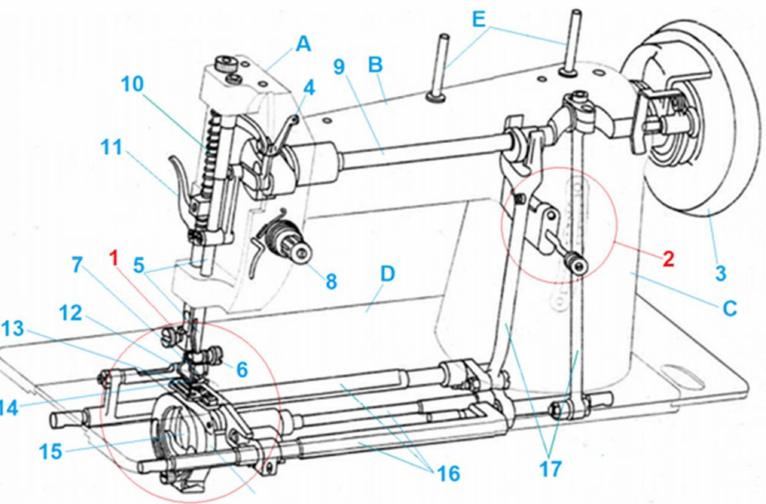
Figure 1. General structure and kinematic system of a lockstitch machine. (A) Sewing Head, (B) Horizontal Arm, (C) Upright Arm, (D) Machine Bed, (E) Spool Pin, (1) Stitch creation mech- anism, (2) Stitch adjustment mechanism, (3) Machine pulley, (4) Thread take-up lever, (5) Needle bar, (6) Needle clam screw, (7) Needle holder (8) Needle thread tension assembly, (9) Arm shaft, (10) Pressure bar, (11) Pressure bar lifter, (12) Pressure foot, (13) Needle, (14) Feed dog, (15) Bobbin case, and (16) Loop-taker (Shuttle), (17) Driving